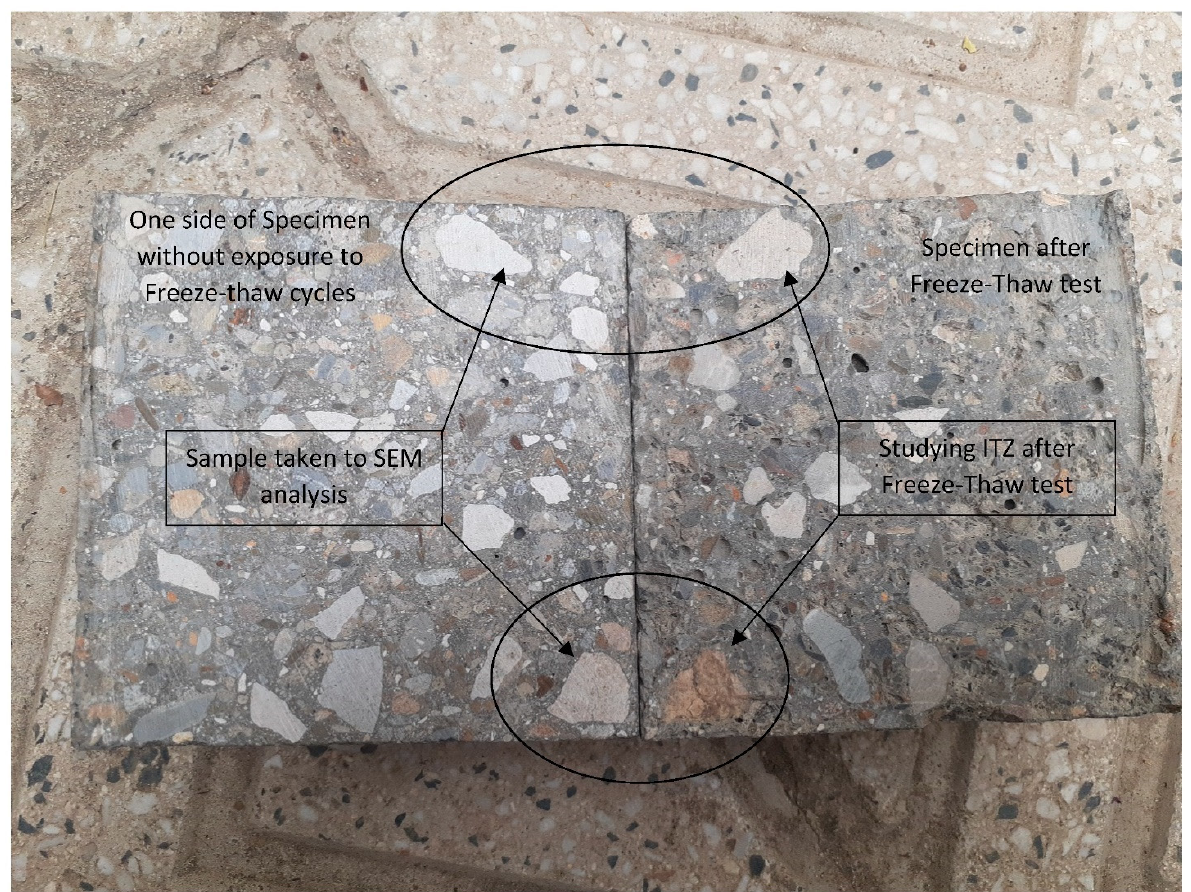
Figure 6. Studying the microstructure of samples taken from a common place to evaluate the effect of deicer salts and freeze-thaw cycles.